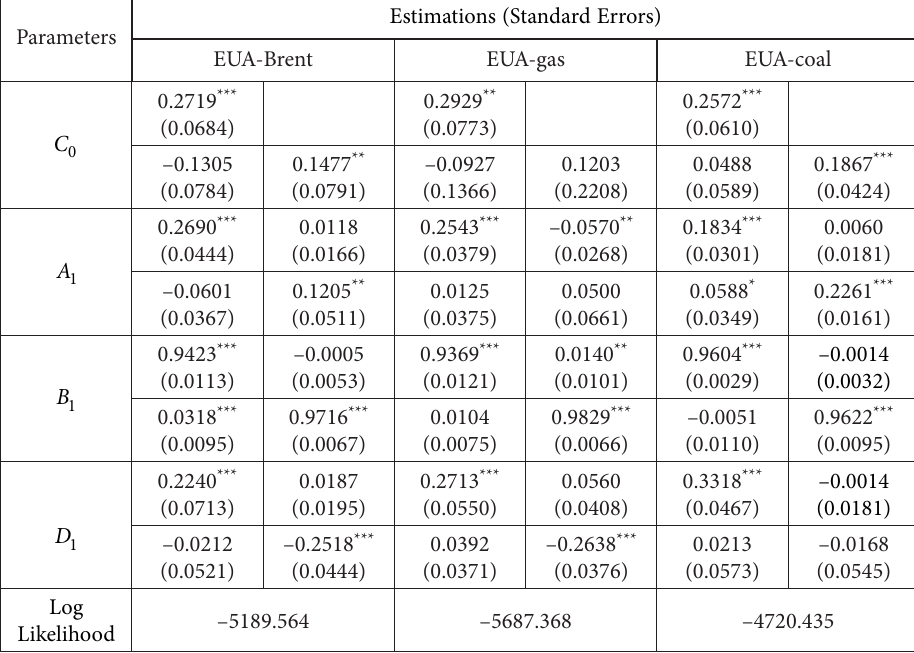
Table 4. Estimation of asymmetric BEKK (1, 1) Model to the daily log returns of EUA and brent, natural gas, coal from 08/04/2008 to 31/12/2012 for 1180